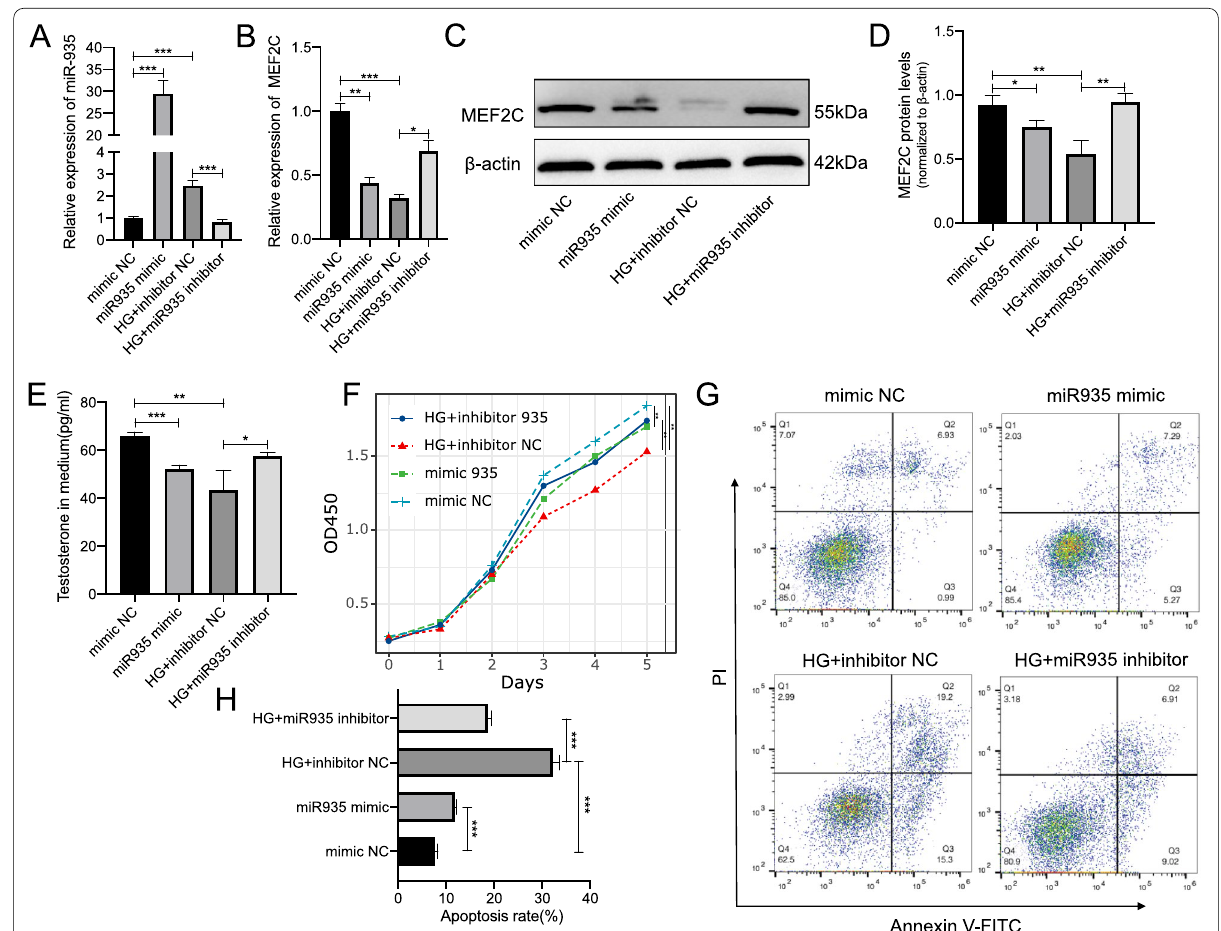
Fig. 6 Modulation of proliferation and apoptosis of Leydig cells by mRNA targets of miR-935. Expression of miR-935 in miR-935 mimic-or miR-935 inhibitor-infected R2C cells at 24 h after culturing in normal or high glucose (HG). Data were normalised to U6 RNA used as an internal control ( A ). Expression of MEF2C determined by RT-qPCR analysis. β-actin was used as an internal control ( B ). Representative immunoblotting ( C ) and cumulative quantification ( D ) of the protein levels of MEF2C in R2C cells transfected with miR-935 mimic, miR-935 inhibitor, mimic NC, or inhibitor NC. Media were collected and assayed for concentration of testosterone using ELISA ( E ). Cell proliferation was assayed using CCK8 ( F ). Detection of apoptotic cells by FACS analysis with FITC-labelled annexin V and PI staining ( G ). Bar graphs represent the percentage of apoptotic cells in each group (H). *p < 0.05, **p < 0.01, ***p < 0.001. n =